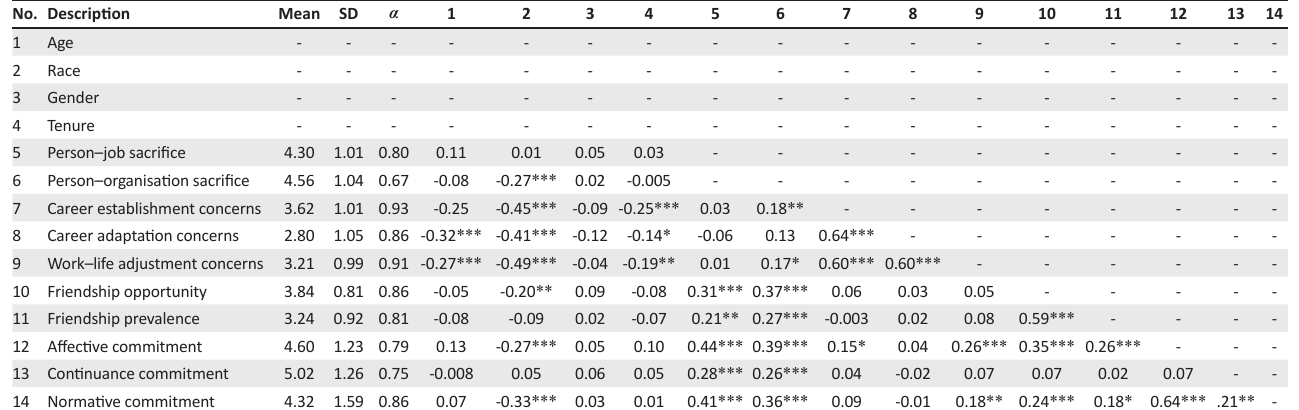
TABLE 1: Descriptive statistics and bivariate correlations. No. Description